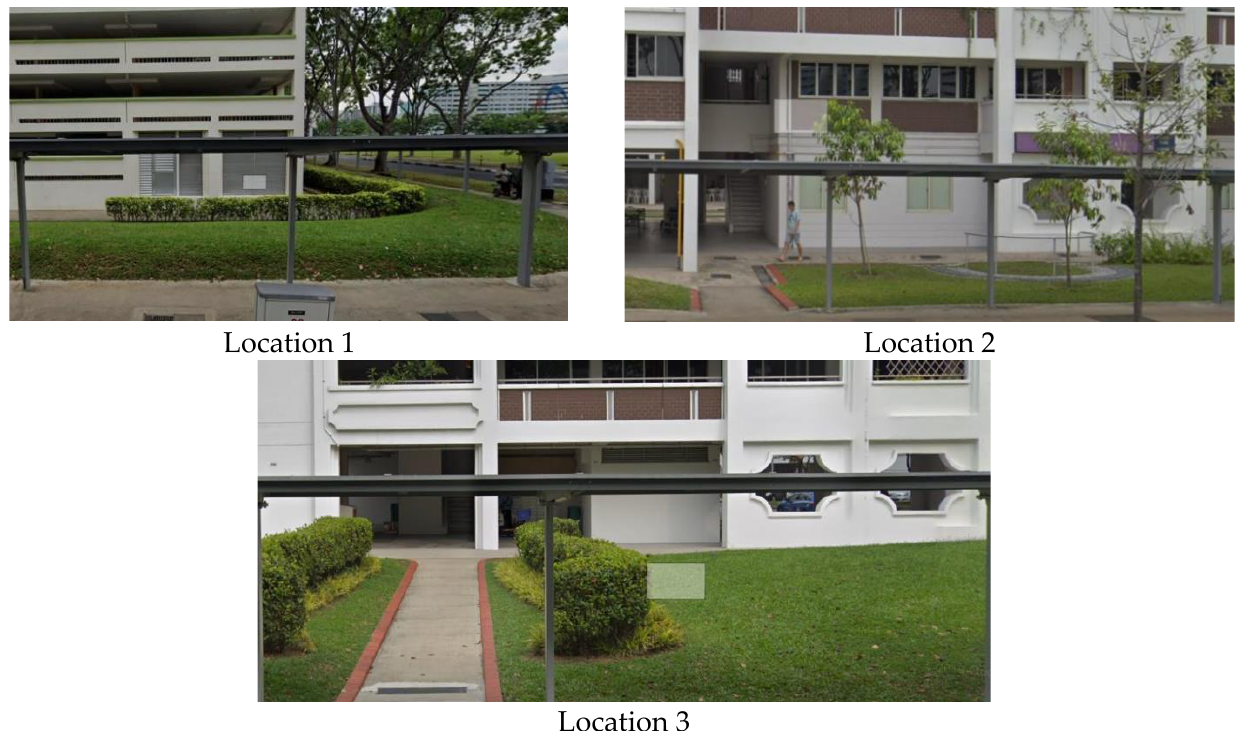
Figure 3. Locations HBD’s covered linkway to install solar PV systems .